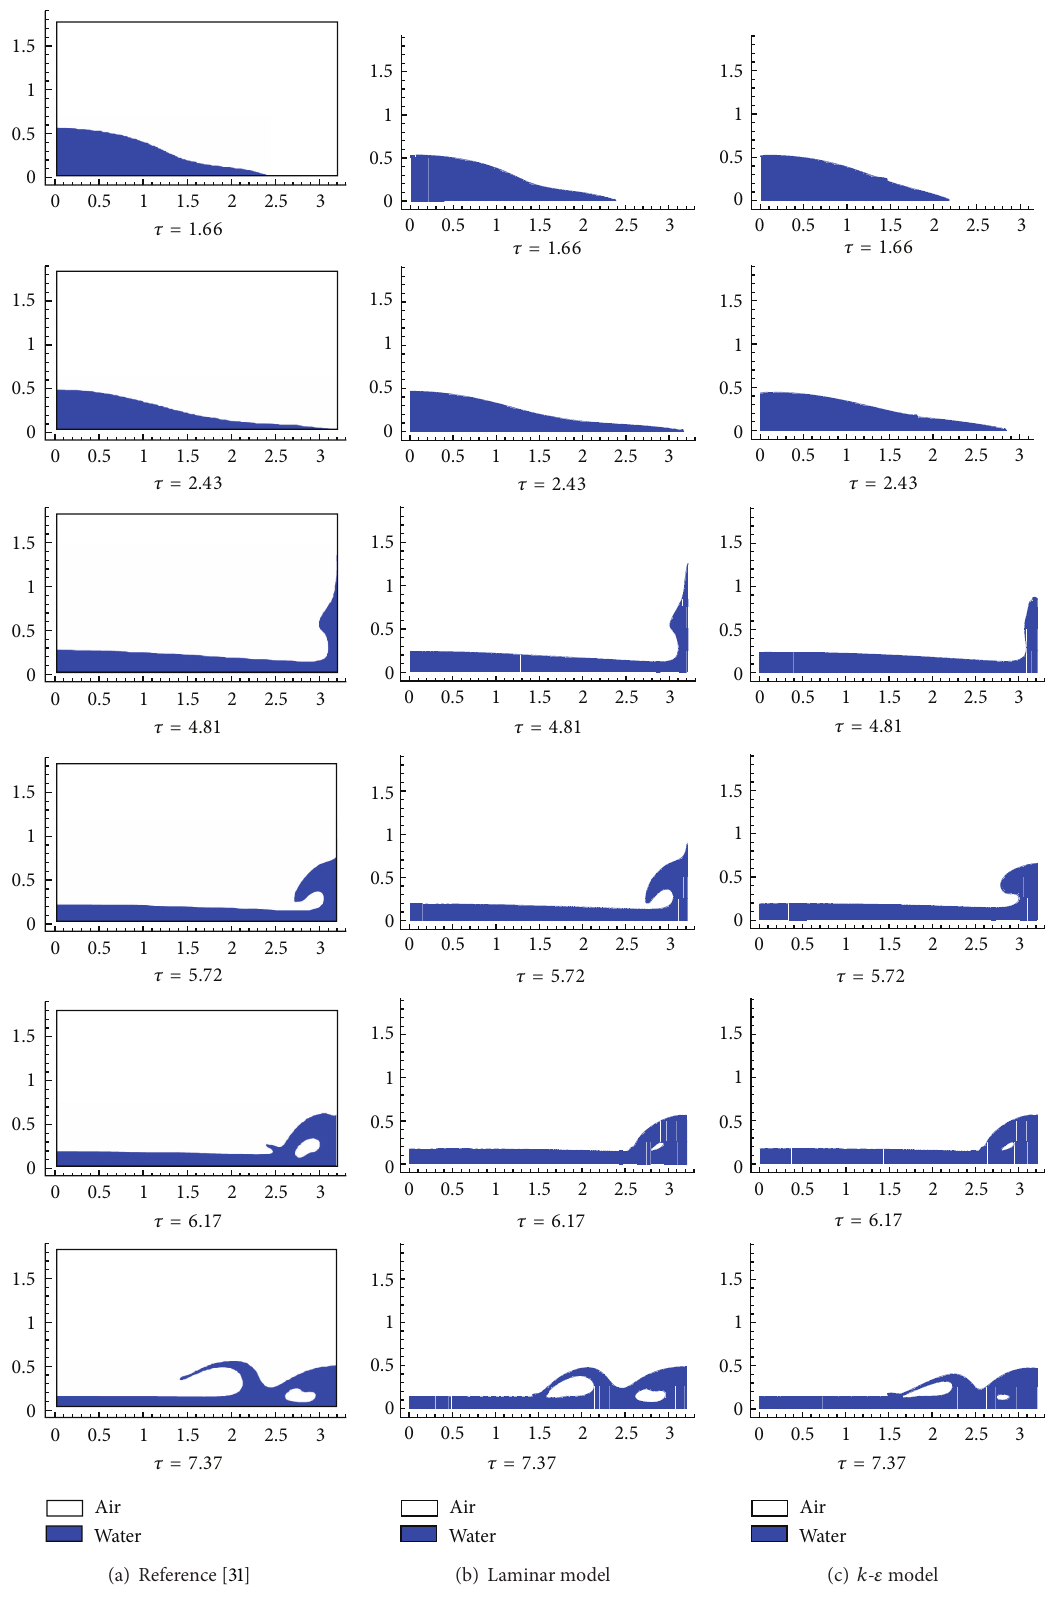
Figure 2: Free surface